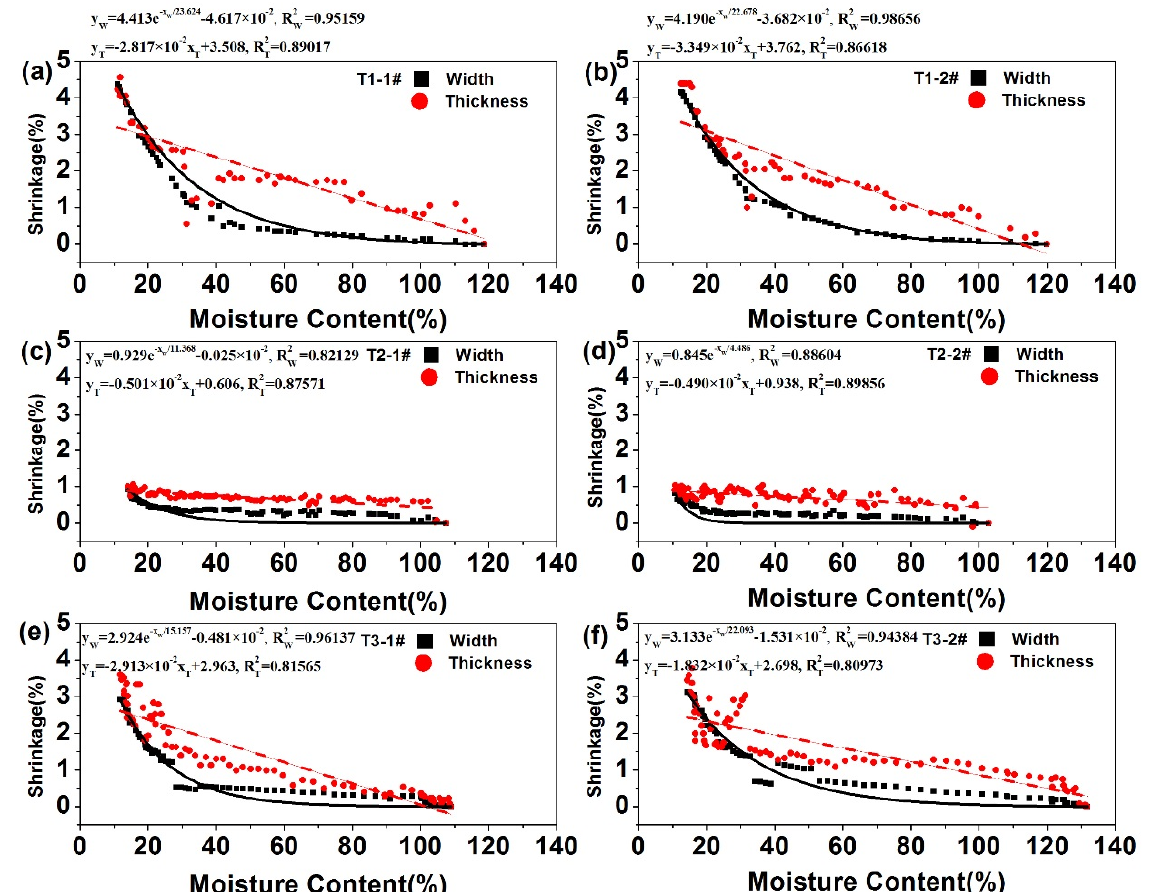
Figure 5. Curve depicting the shrinkage rate of T1, T2, and T3 during drying. 1# and 2# shrinkage rate curves of T1 ( a ), ( b ); 1# and 2# shrinkage rate curves of T2 ( c ), ( d ); 1# and 2# shrinkage rate curves of T3 ( e ), ( f ).